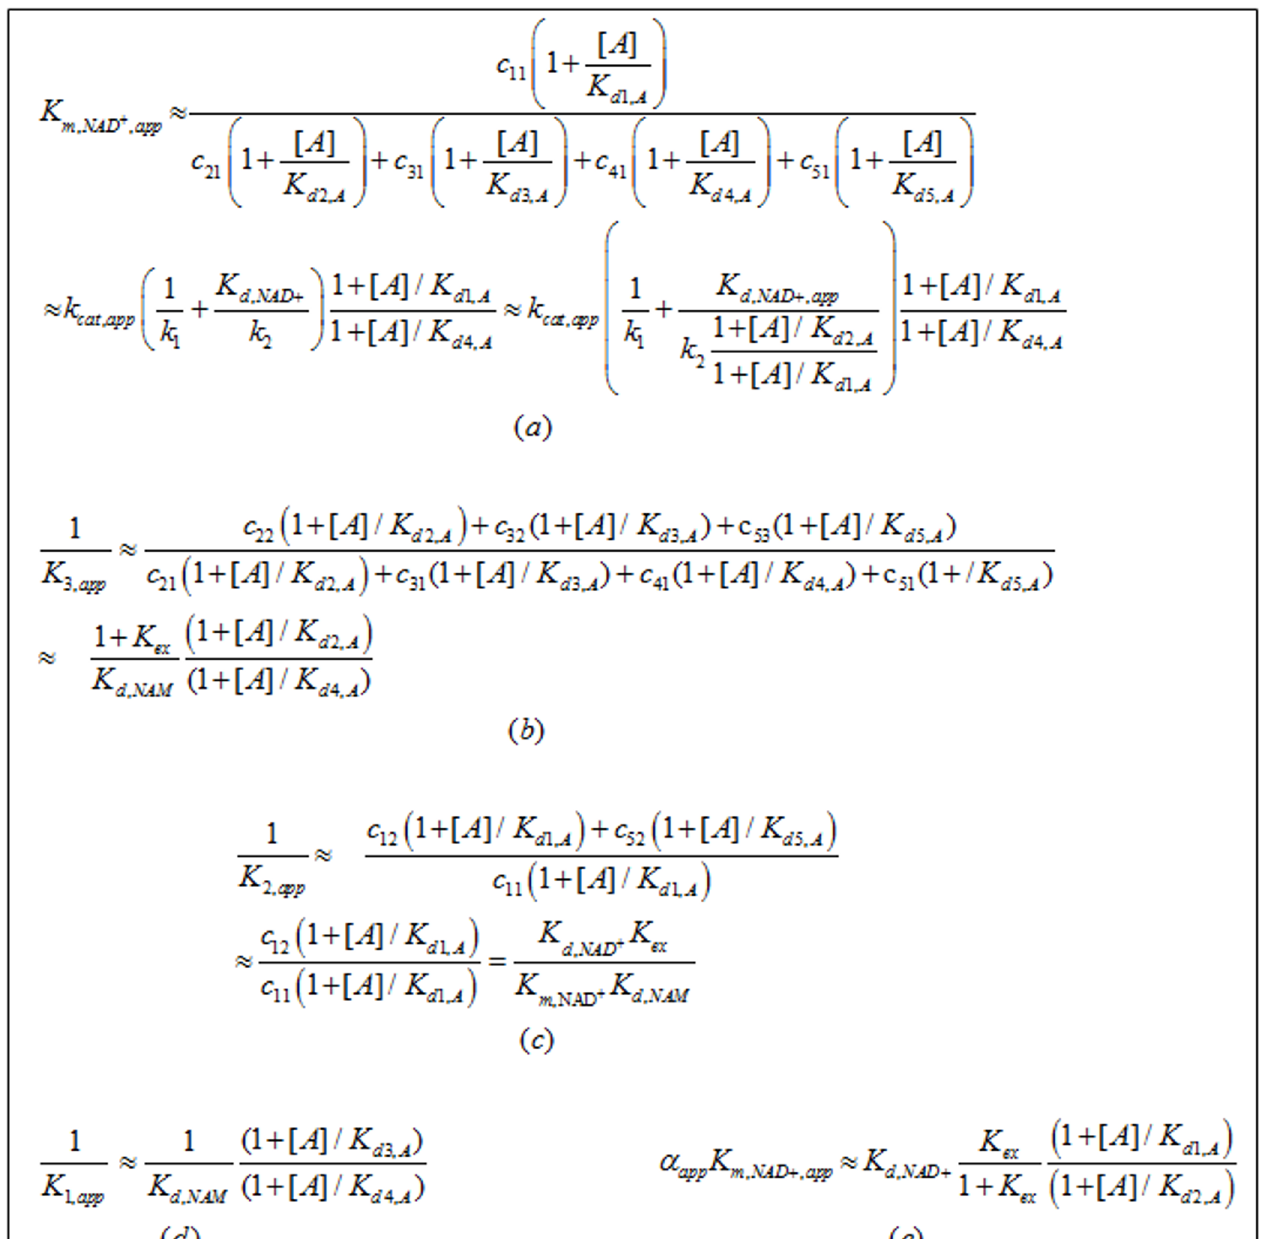
Fig 2. Modulated expressions for the steady state constants in Appendix A1 according to the rapid equilibrium segments approximation. c ij expressions are provided in the Appendix A2. In particular, we emphasize that assumption (ii) may not hold for several mammalian sirtuins, but we apply this approximation to simplify the equations and provide physical insight. The general equations without this approximation can readily be derived using the principles introduced.